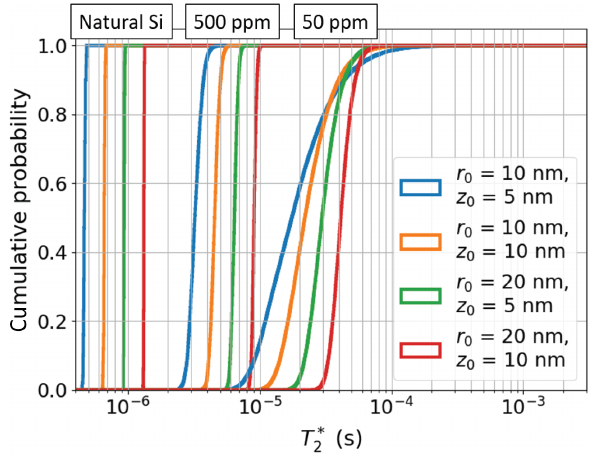
FIG. 6. Cumulative probability distributions of T ∗ for various 2 quantum dot shapes and enrichment levels of 29 Si (natural, 500 ppm, and 50 ppm) using the simple model of Eq. (5). Other nuclear spins are not being considered here but may be important depending upon the